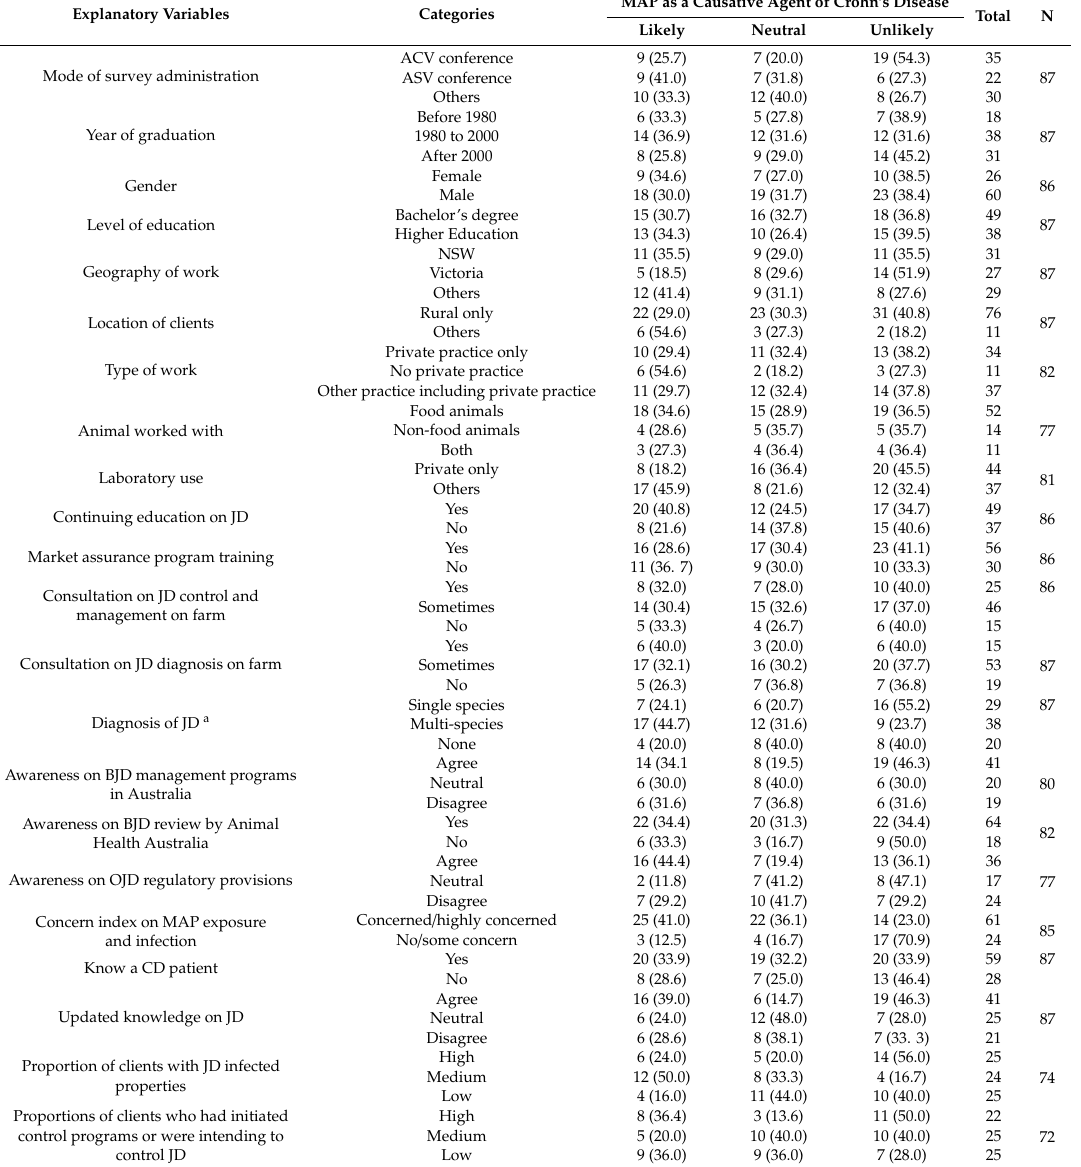
Table 2. Veterinarians’ perceptions for MAP as a causative agent of Crohn’s disease cross-tabulated against the assessed explanatory variables based on a study conducted in Australia in